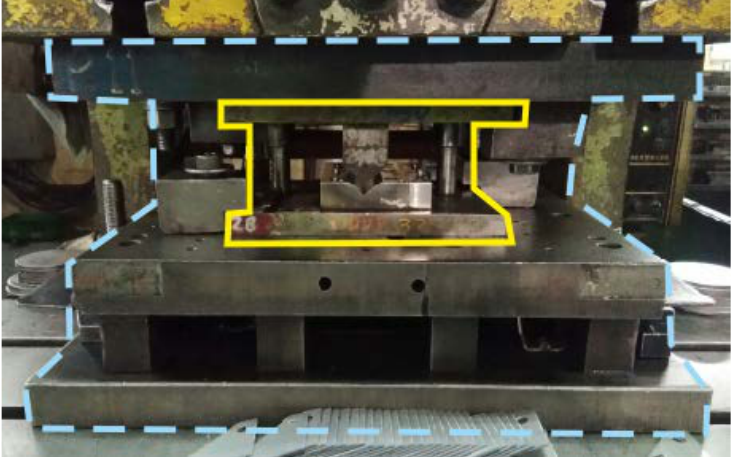
Figure 1: Construction of QDCS. Blue dashed line is showing the construction of QDCH and yellow full line show the construction of QDCD.